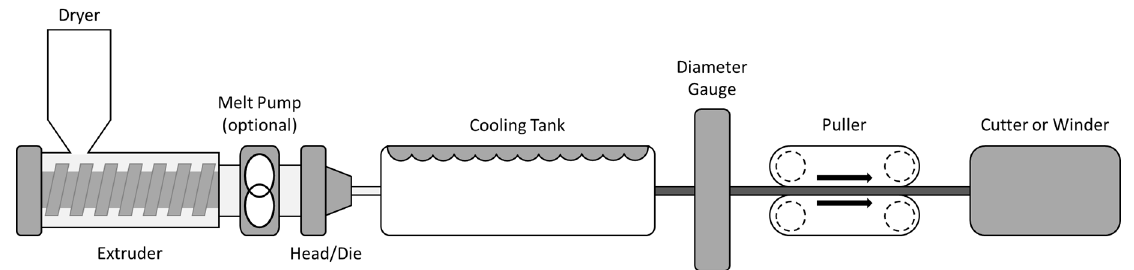
Figure 5. Typical medical tubing extrusion line. This type of extrusion line contains several pieces of equipment, including a drying system, an extruder, a die, a cooling tank, a take-up device